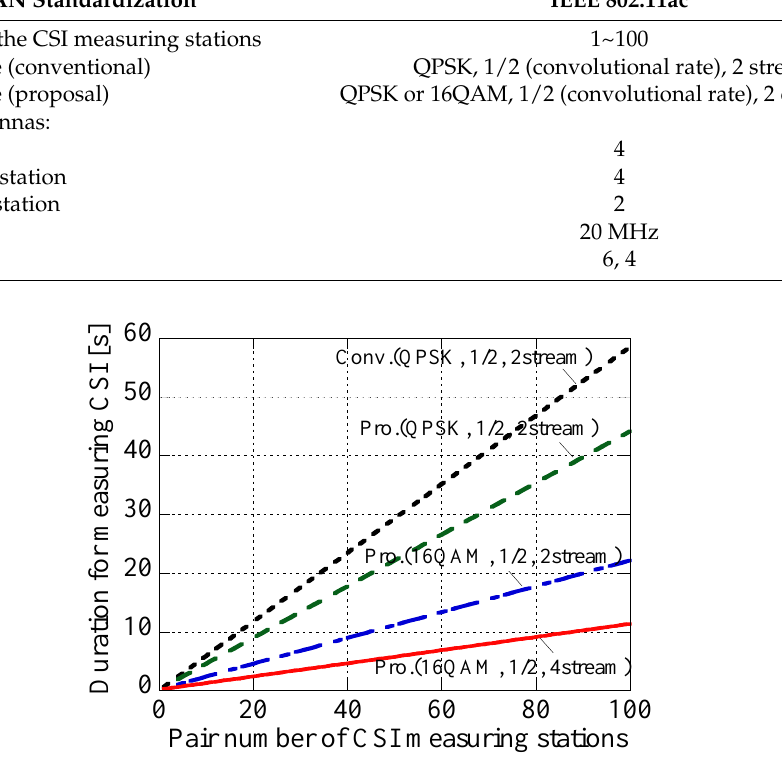
Figure 4. Duration results for measuring CSI.